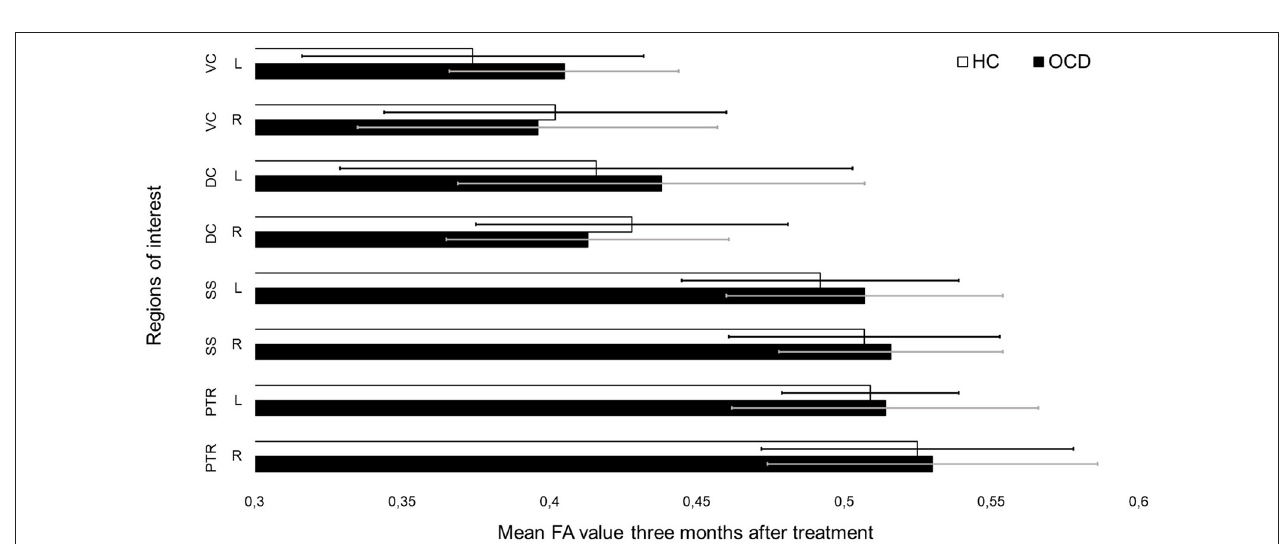
FIGURE 3 | Mean fractional anisotropy (FA) values for each region of interest in patients and controls before treatment.